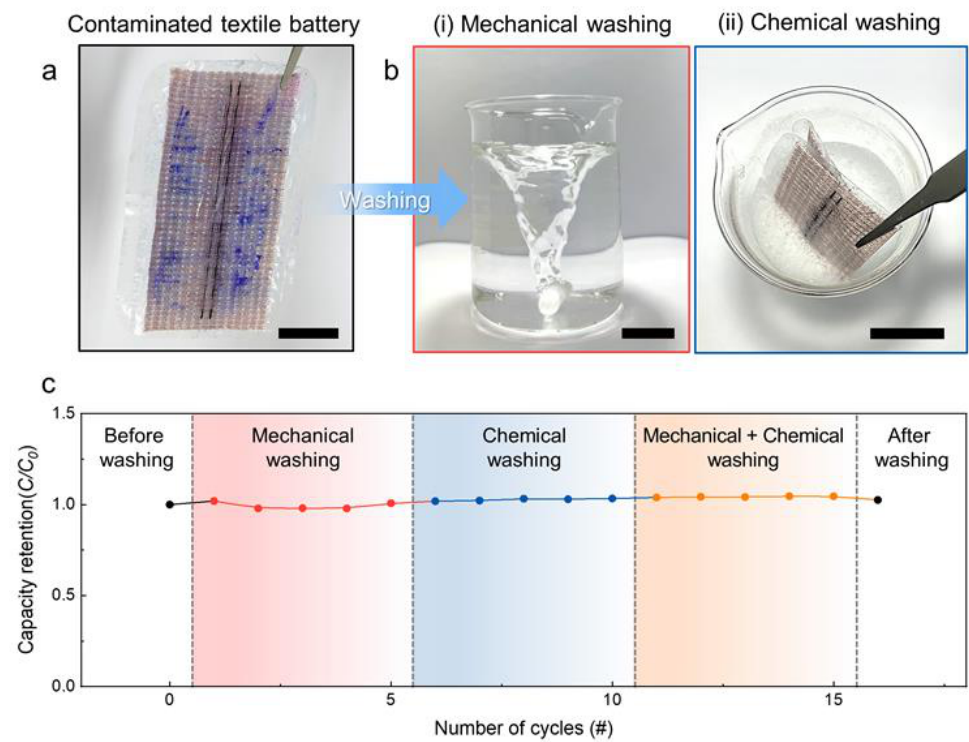
Figure 5. Optical photographs showing the ( a ) contaminated vacuum − packaged MnO 2 − Zn textile battery and ( b ) steps for ( i ) mechanical and ( ii ) chemical washing (all scale bars are 2 cm). ( c ) Capacity retention for the three distinct types of washing: mechanical, chemical, and combined mechanical and chemical.